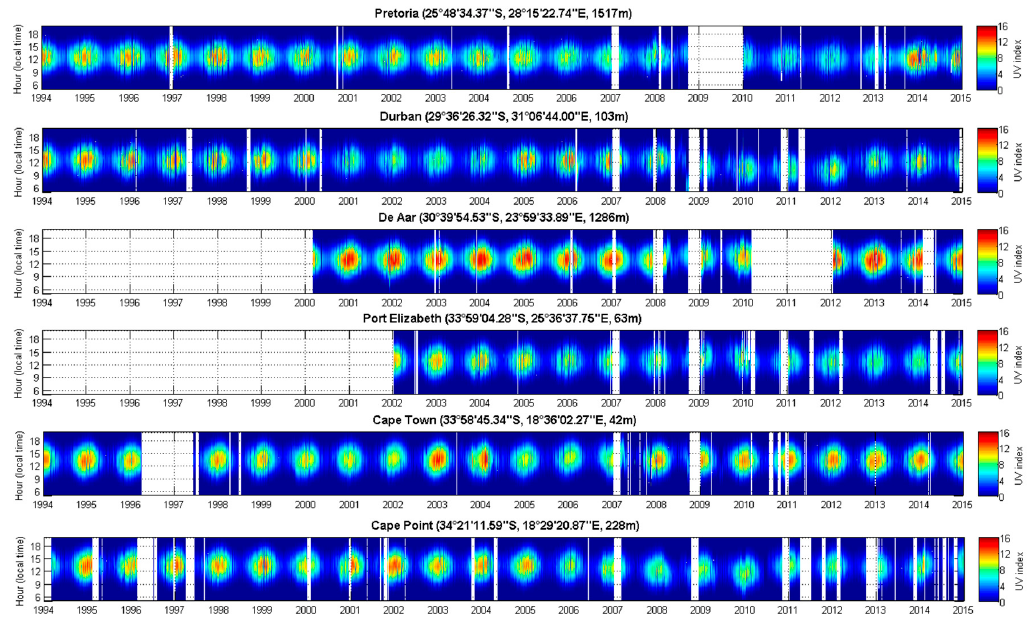
Figure 2. UV index observations as a function of day and hour per day for Cape Point, Cape Town, Durban, De Aar, Port Elisabeth, and Pretoria from 1994 to 2015.